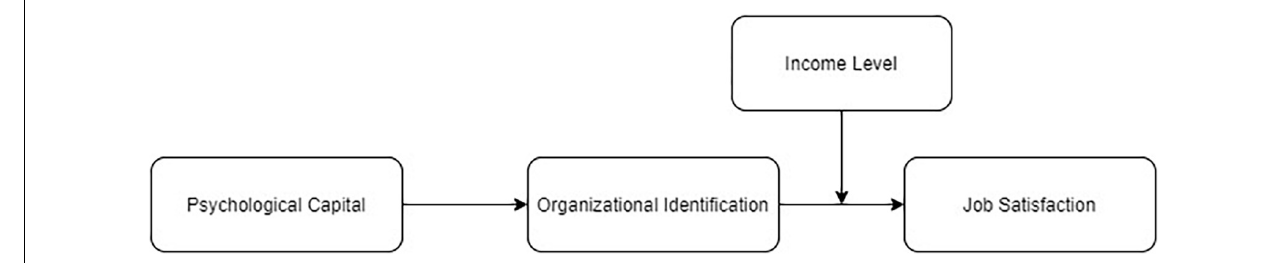
FIGURE 1 | Hypothesized